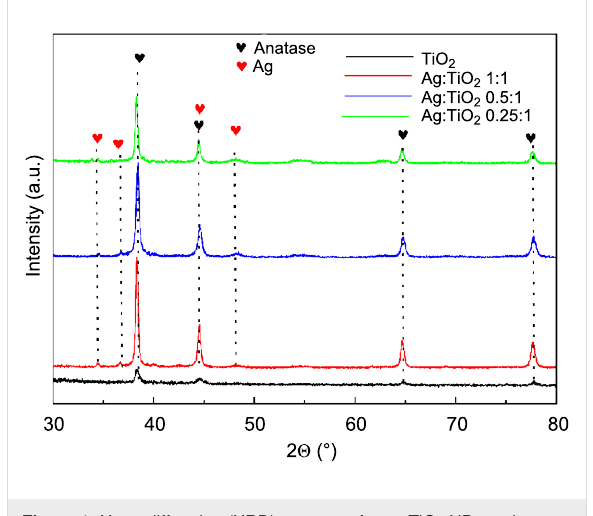
Figure 1: X-ray diffraction (XRD) patterns of pure TiO 2 NPs and Ag–TiO 2 nanocomposites at different ratios.